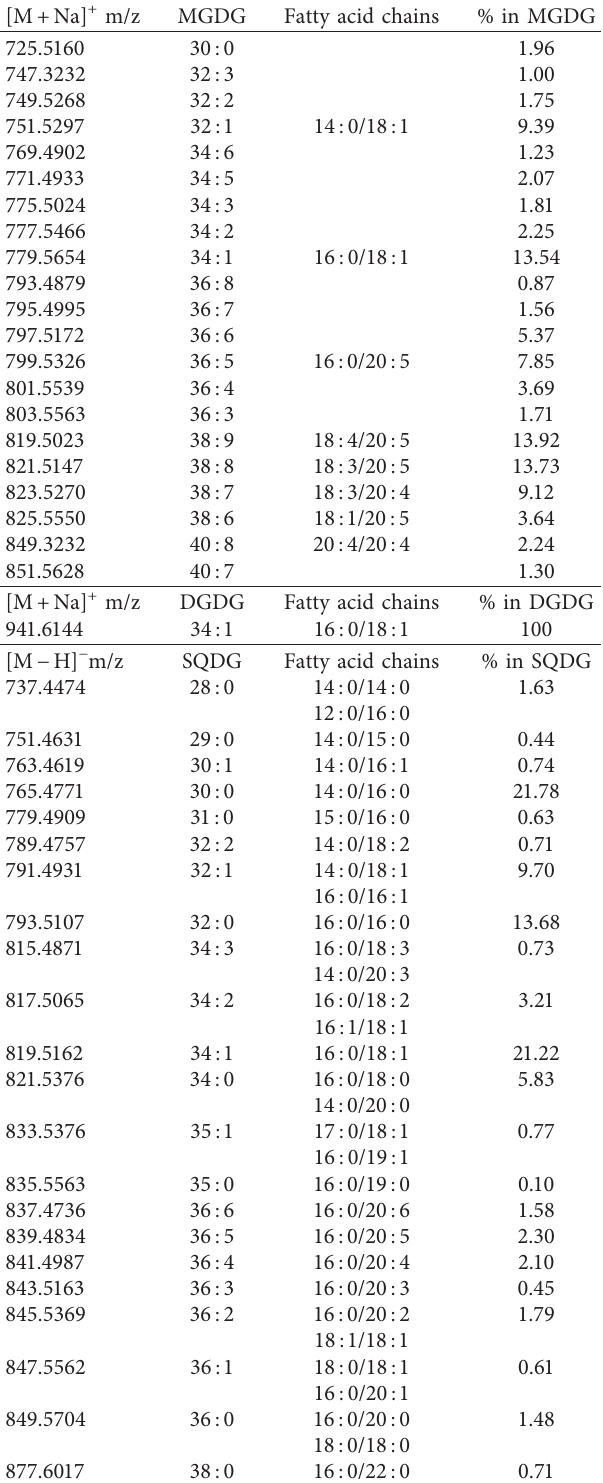
Table 4: Molecular species of glycolipid including MGDG, DGDG, and SQDG groups identified by HPLC-HRMS as negative [M − H] − ions and positive [M +Na] + ion, and identification as phospholipid and fatty acyl composition confirmed by the analysis of the LC-MS/ MS spectra of each